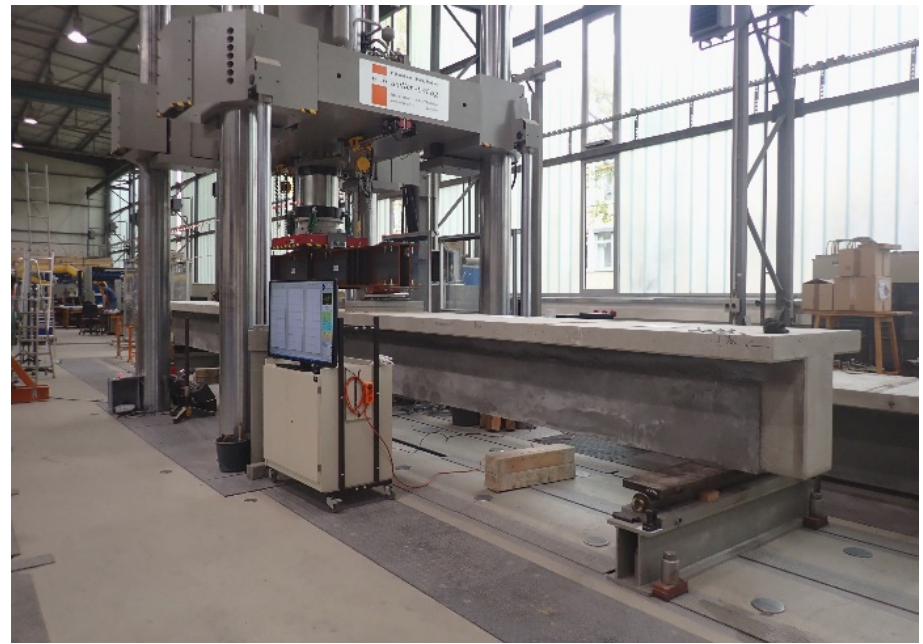
Figure 7. Large-scale component test during the individual approval process. (Photo: CARBOCON